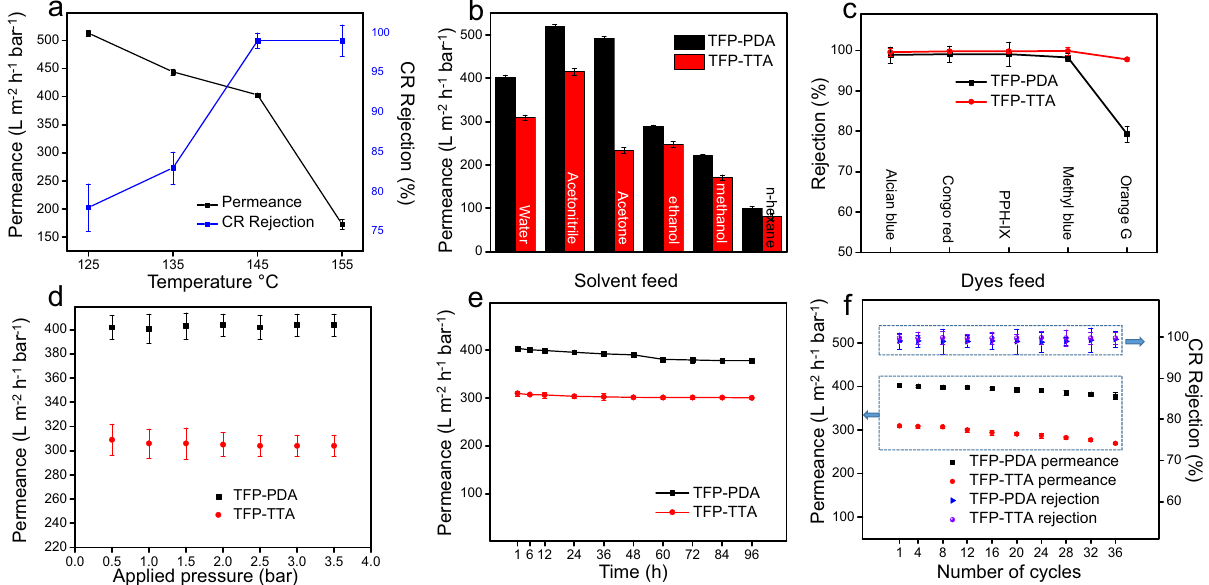
Fig. 5 Performance evaluation of COF membranes. a Permeance and CR rejection of membranes fabricated at different temperatures after 18 h. b Permeance of various solvents. c Rejection (%) of dyes. d Permeance at different pressures. e Long-term operation. f Permeance and CR rejection after speci fi ed